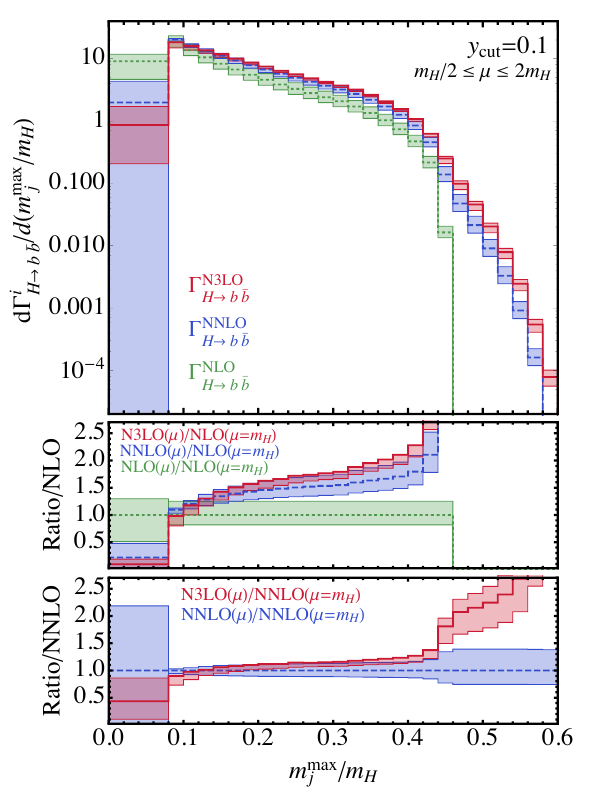
Figure 9 . The mass of the jet (divided by m H ) for the jet with maximum energy in the Higgs rest frame at NLO, NNLO, and N 3